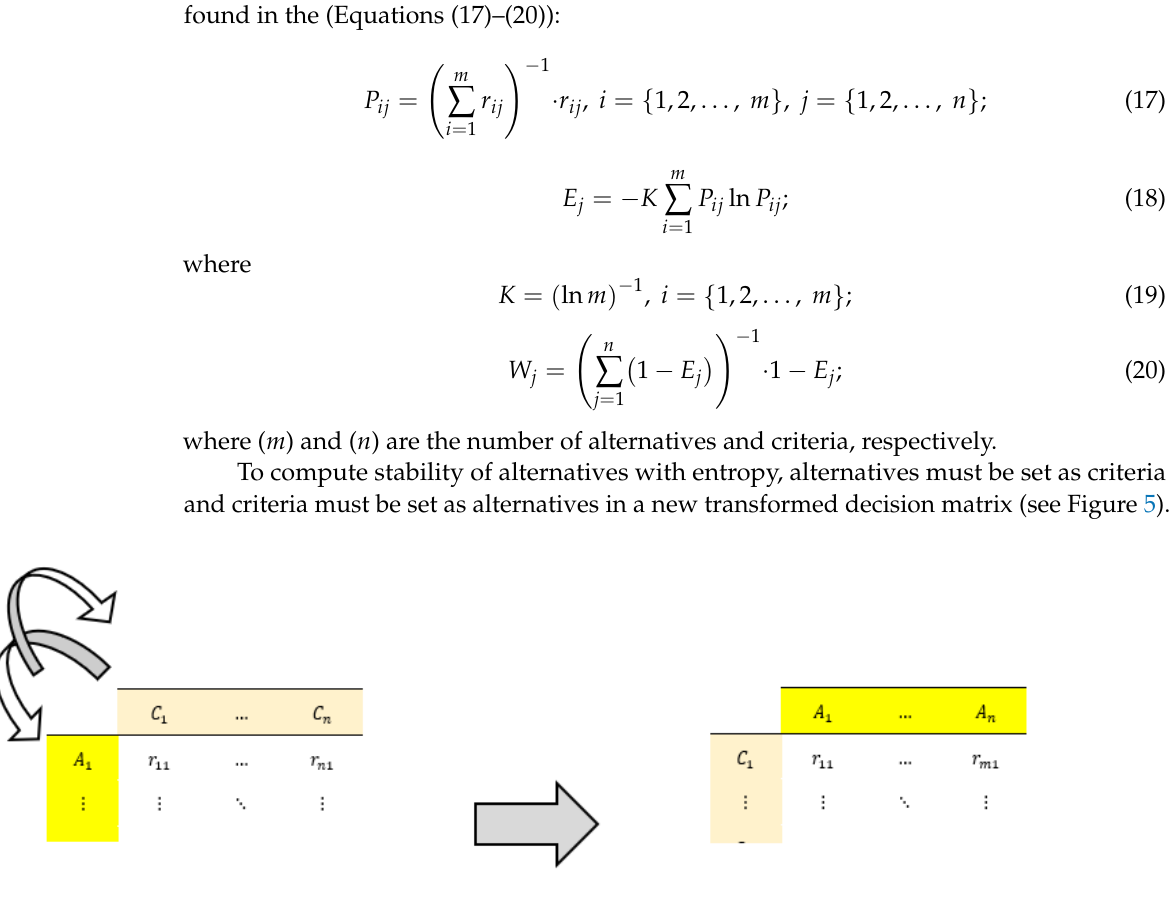
Figure 5. The transformed decision matrix for the computation of each alternative’s stability with entropy.